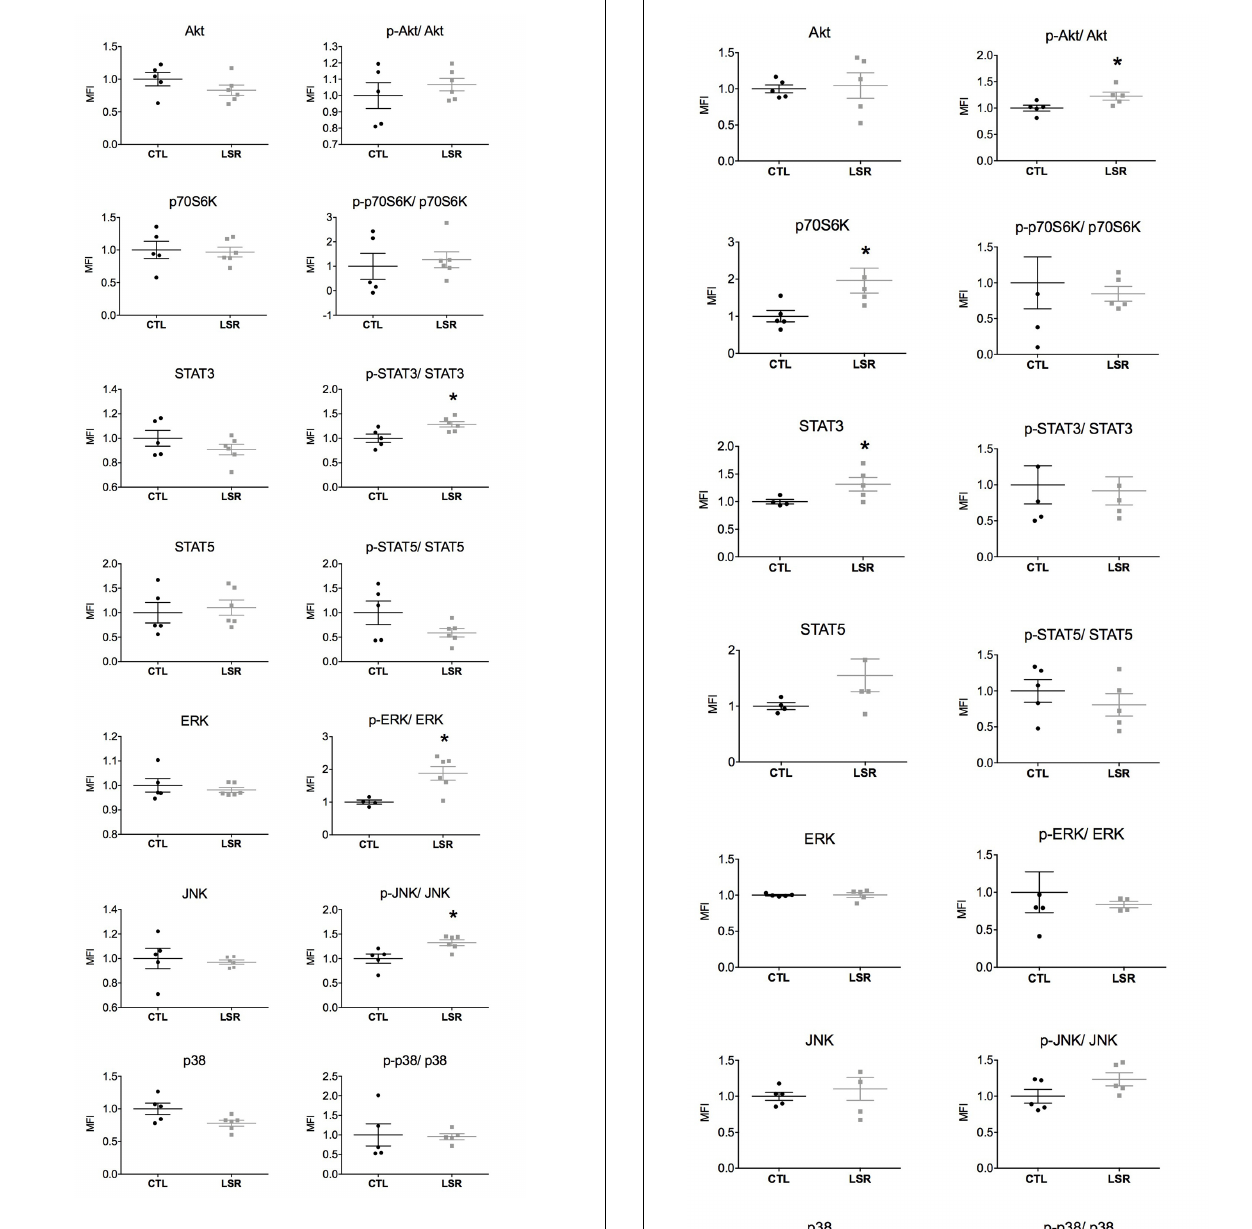
FIGURE 1 | Cortical expression and activation (phosphorylated/total protein) of intracellular signaling pathways in rats from the laser (LSR) and control (CTL) groups. Data are presented as individual points to show dispersion and as mean and standard error of the mean ( ± SEM). Significant increases in the activation of STAT3, ERK, and JNK were found in the laser group when compared to the control group (*). Data were normalized to the mean fluorescence intensity (MFI) of the control group ( p < 0.05; Mann-Whitney U-Test). (Salehpour et al., 2019). This difference may be related to the different treatment protocols. They used a laser treatment protocol of 810 nm wavelength for five consecutive days (with a fluence of 33.3 J/cm 2 ), while our protocol consisted of 58 consecutive days of laser treatment with 810 nm wavelength and fluence of 535.7 J/cm 2 . Therefore, our laser treatment was